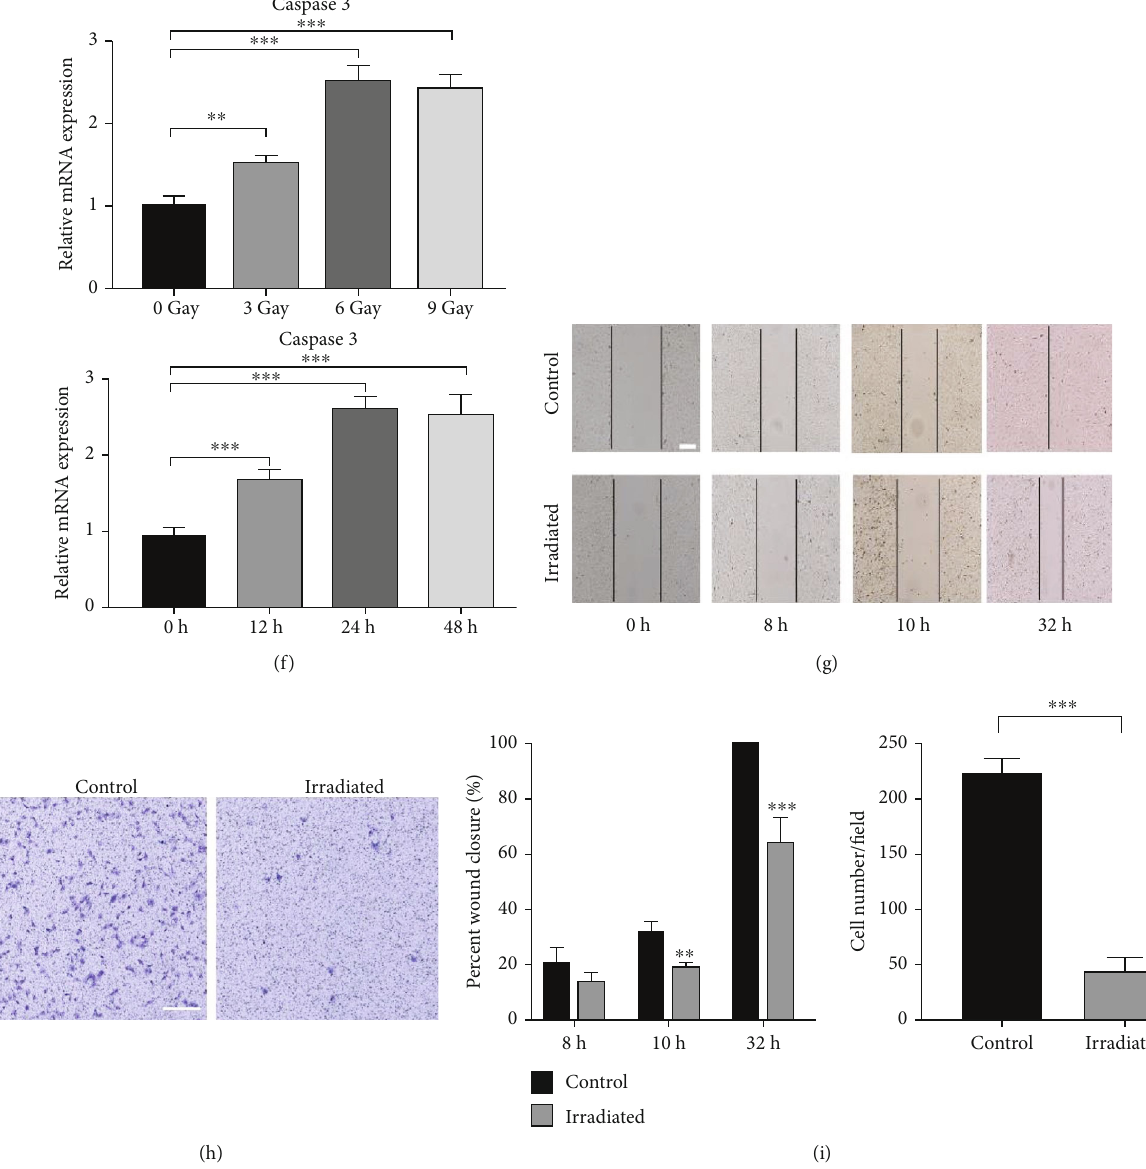
Figure 1: Irradiation inhibits the function of osteoblast progenitor cells. (a) ALP staining in control and irradiated MC3T3 (scale bar, 100 μ m). (b) Alizarin red staining in control and irradiated MC3T3. (c) Statistics of ALP and Alizarin red in control and irradiated MC3T3. (d) Hoechst staining in control and irradiated MC3T3. The yellow arrowhead points to apoptotic cells (scale bar, 25 μ m). (e) Statistics of Hoechst in control and irradiated MC3T3. (f) Apoptosis-speci fi c gene expression in di ff erent times and doses with X-ray cells. (g) Scratch test in control and irradiated MC3T3. (h) Transwell in control and irradiated MC3T3 (scale bar, 100 μ m). (i) Statistics of scratch and transwell in control and irradiated MC3T3. All data are mean ± SD ; ∗ P < 0 : 05 , ∗∗ P < 0 : 01 , and ∗∗∗ P < 0 : 001